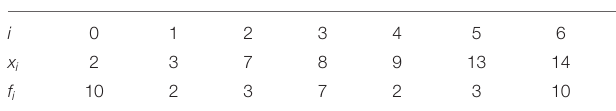
TABLE 2 | Positive data from Sarfraz et al. [24].